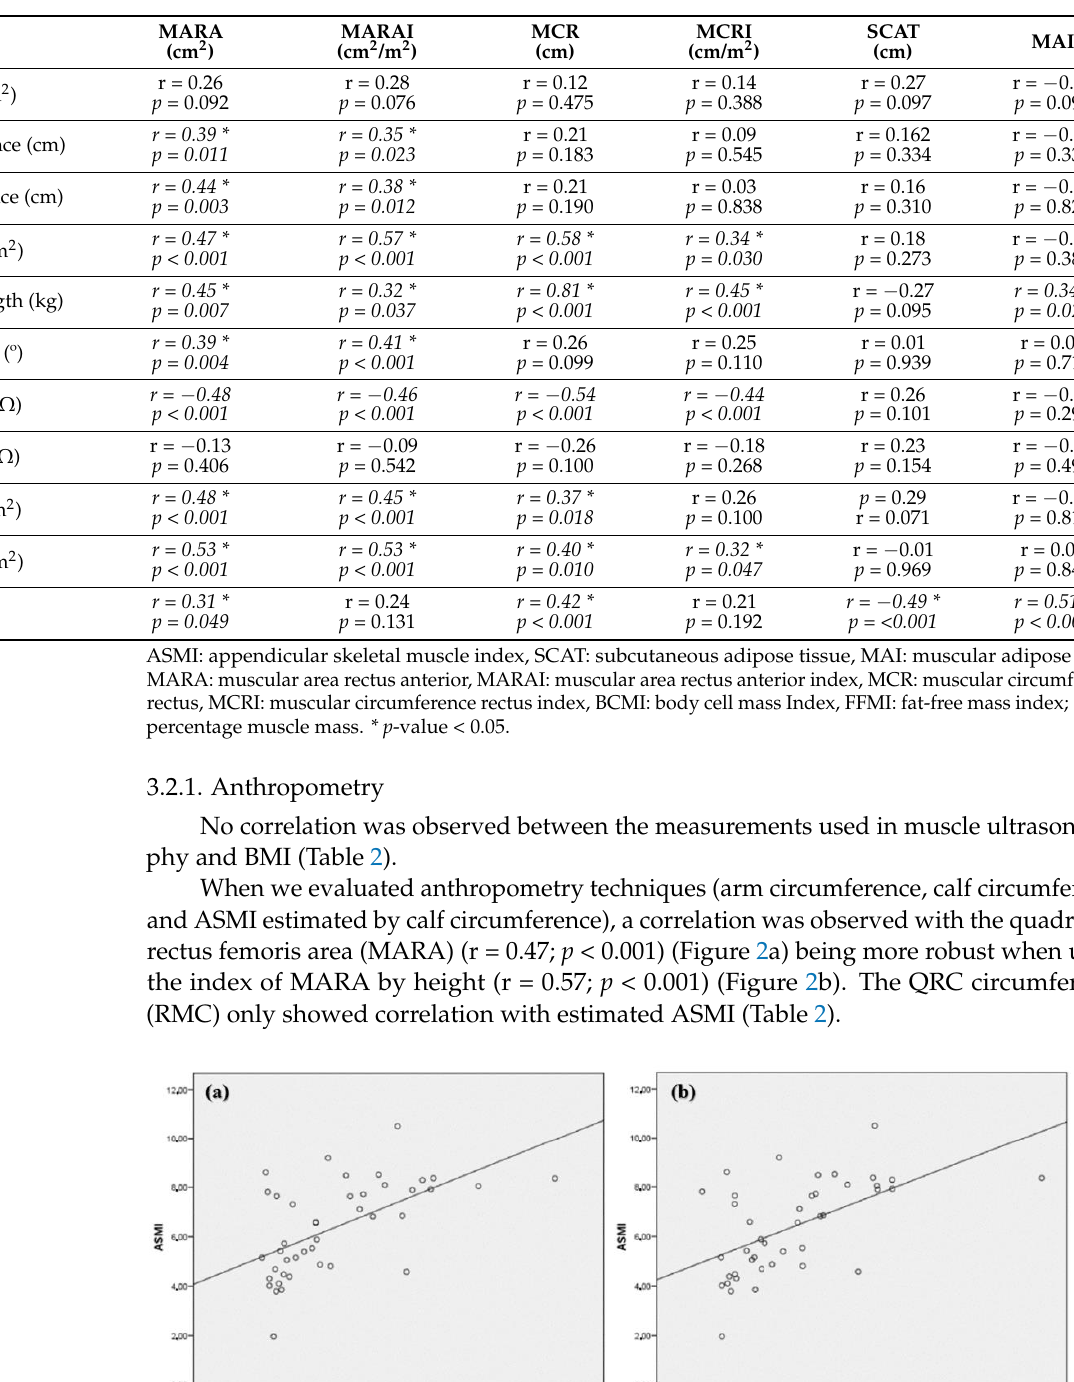
Table 2. Correlations of body composition parameters measured by ultrasonography with other morphofunctional assessment parameters (anthropometry, handgrip strength and impedanciometry).